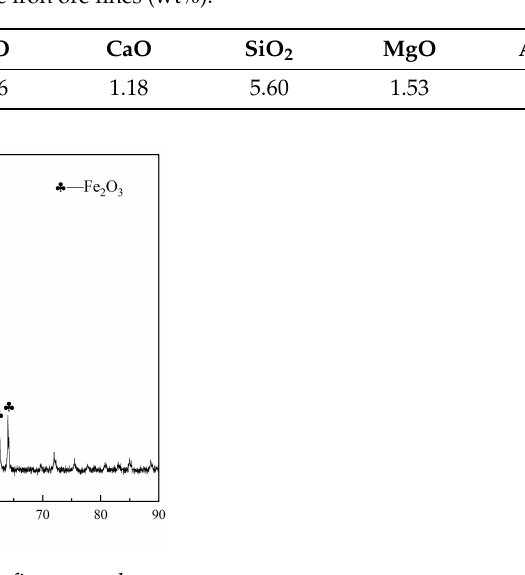
Figure 1. X-ray diffraction of iron ore fines sample.